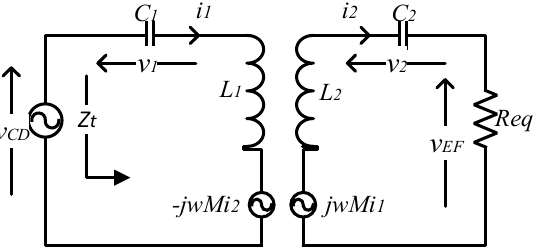
Figure 5. Equivalent circuit of a WPT system with a serial–serial compensation network. The total equivalent impedance of the WPT system, seen from the ground side, is given in (2):